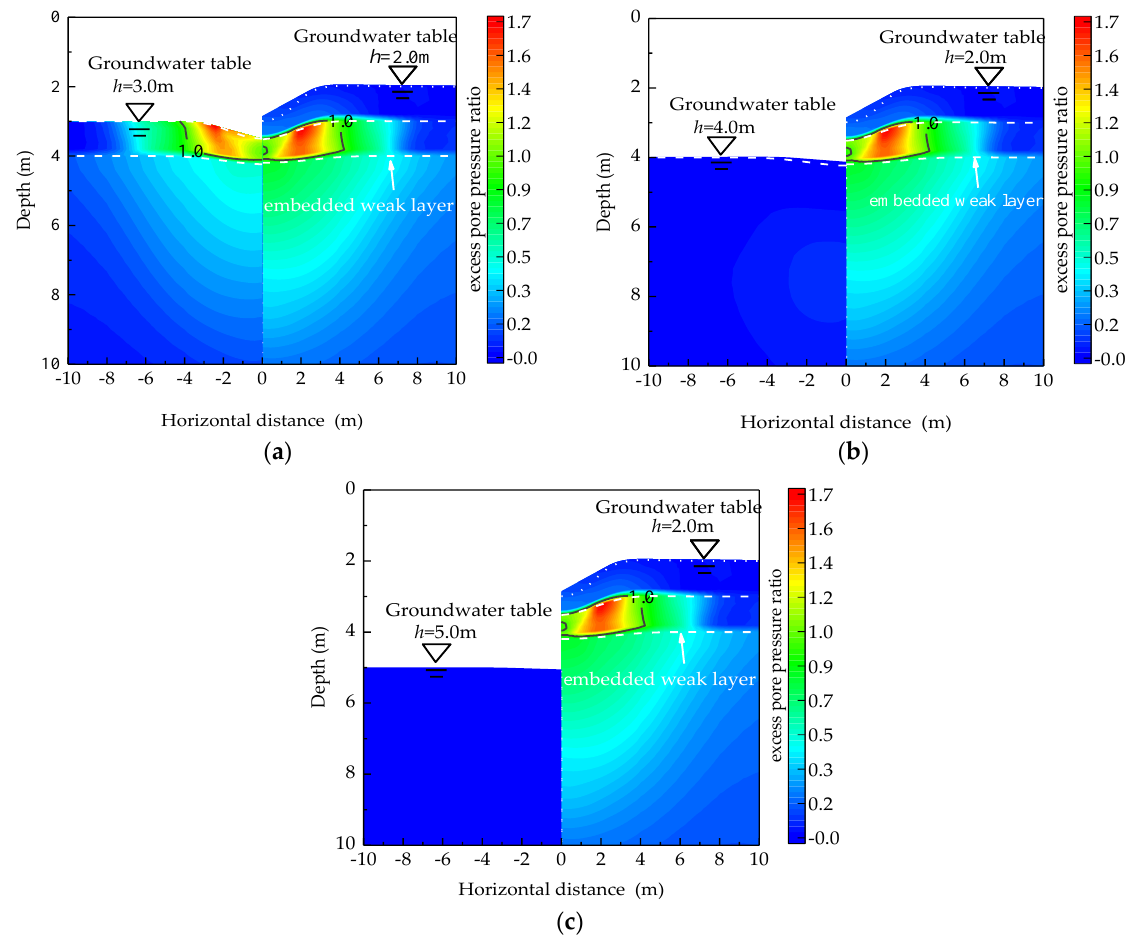
Figure 21. Distributions of excess pore water pressure ratio in grounds of different levels of ground- water. ( a ) groundwater level: 3 m; ( b ) groundwater level: 4 m; ( c ) groundwater level: 5 m.